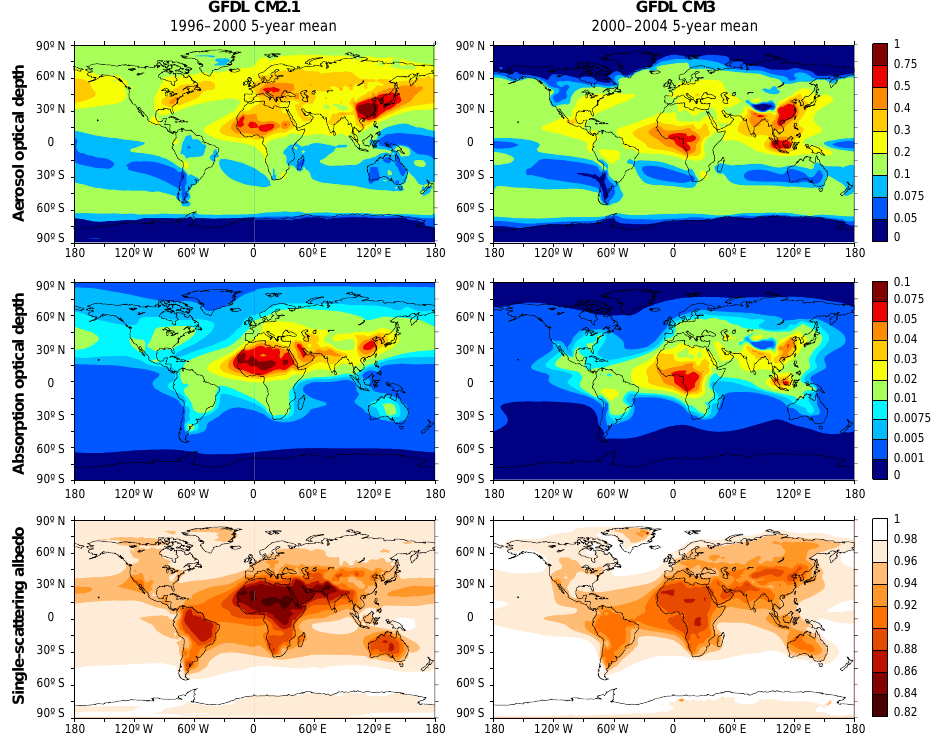
Figure 1. Model-derived total aerosol optical properties. Five-year annual means from a five-member historical simulation ensemble: CM2.1 present-day from 1996–2000 and CM3 present-day from